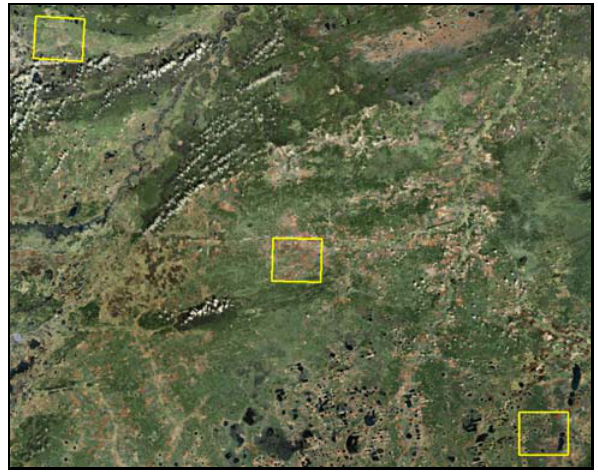
Figure 6 Localization of SASCHA test sites (Western Siberia) (left: Kaskara, middle: Omutinsky, right: Ishin) 2.4.2